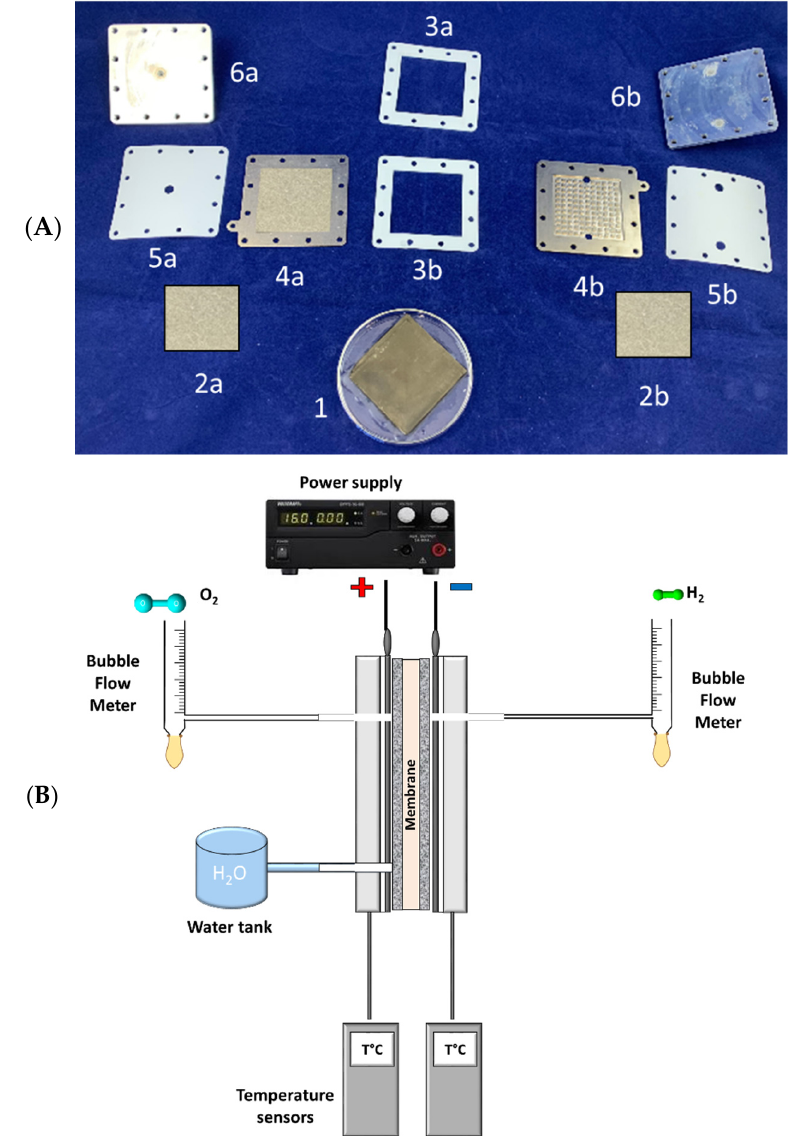
Figure 4. ( A ) Electrolyzer cell elements: CCM (1), titanium porous electrodes (2a, 2b), teflon seals (3a, 3b, 5a, 5b), cathodic (4a) and anodic (4b) current collectors, end plates (6a, 6b). ( B ) Schematic view of the experimental setup for the electrolysis tests.